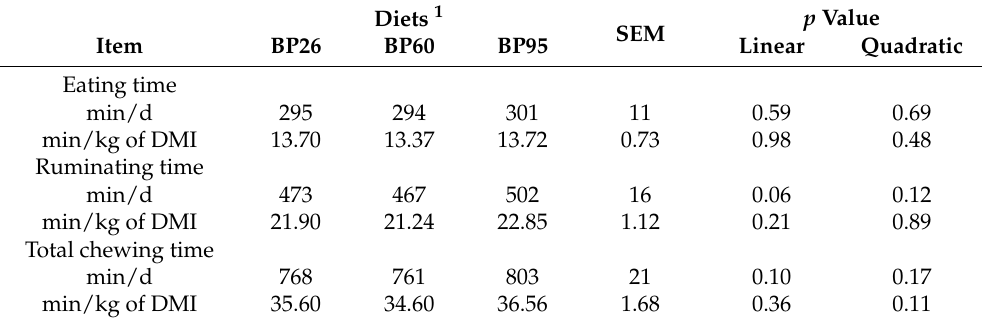
Table 4. Effect of replacing human-edible feed ingredients with byproducts on chewing activities.